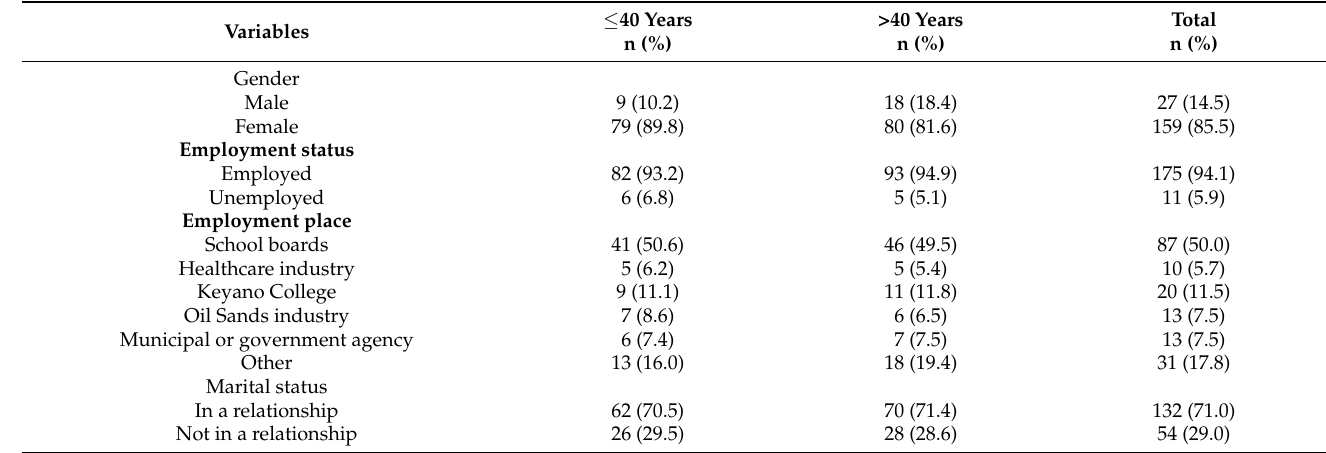
Table 1. Socio-demographic information, clinical, and wildfire-related